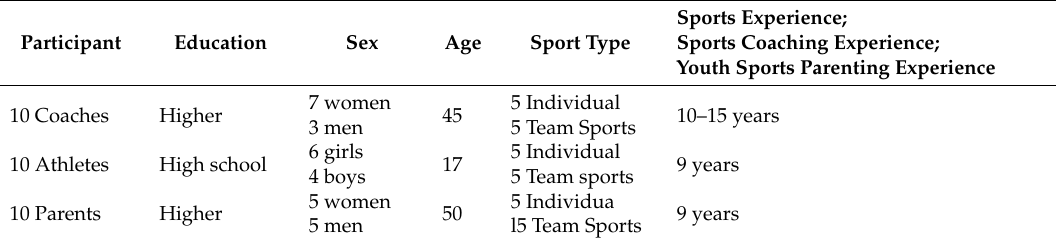
Table 2. Demographic characteristics of research participants (Study 2)